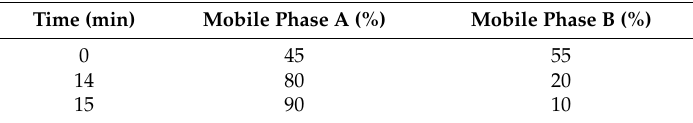
Table 1. Gradient elution profile. Mobile phase A: acetonitrile; mobile phase B: 10 mM phosphate buffer (pH